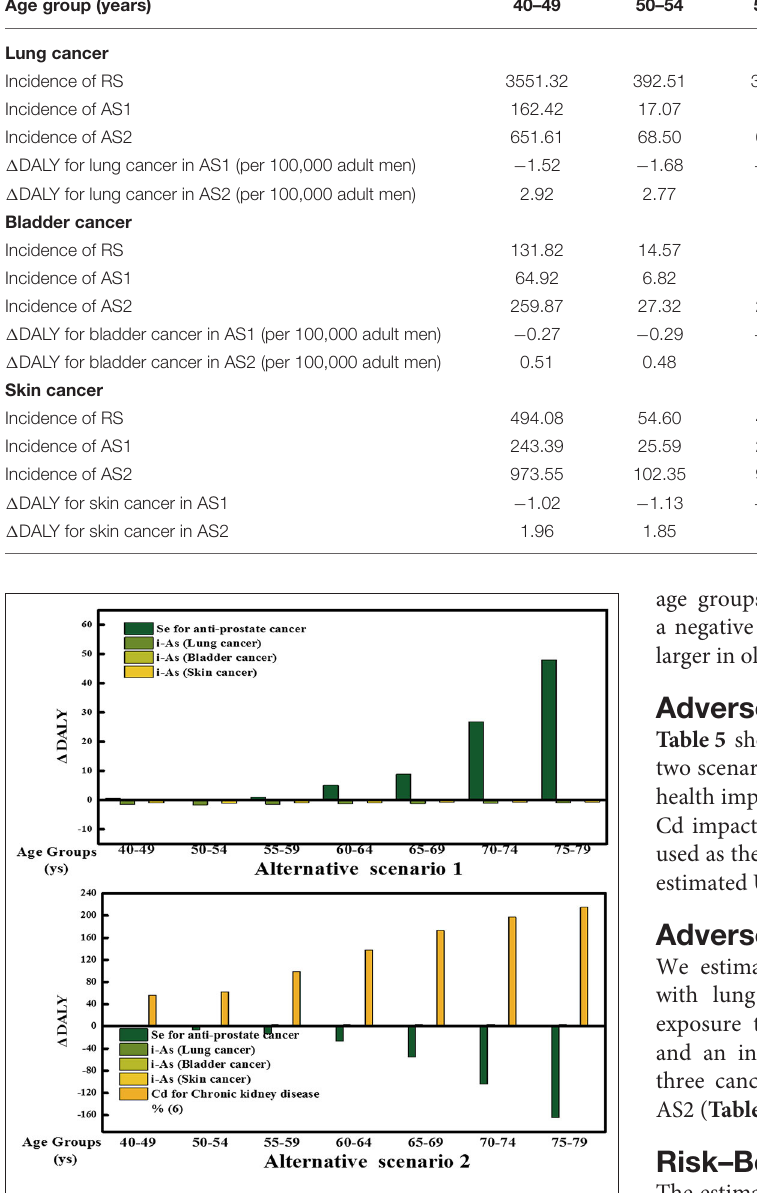
FIGURE 1 | Difference in DALYs by scenario and outcome. Contribution of each health outcome to the overall DALY difference estimates for each AS for